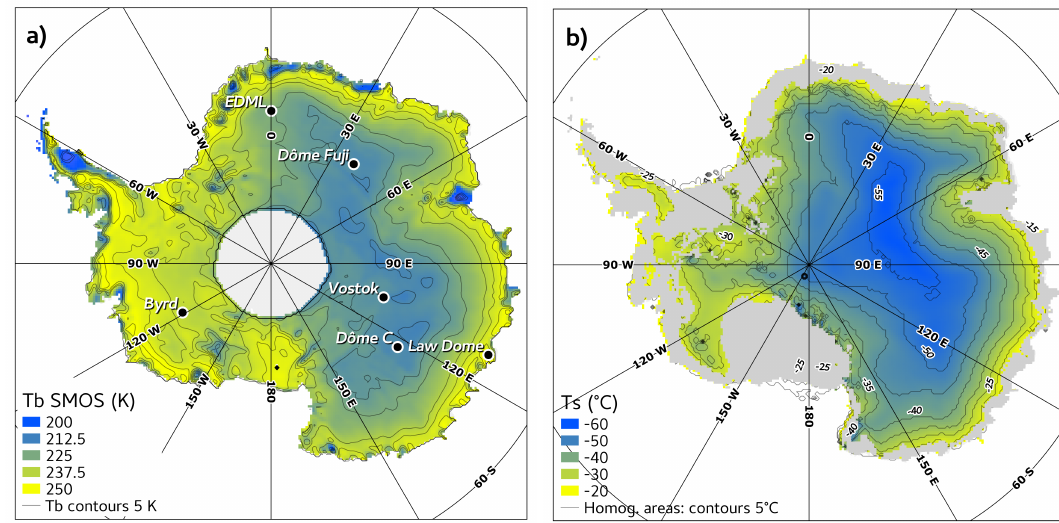
Figure 1. ( a ) Brightness temperature T B measured by the Soil Moisture and Ocean Salinity (SMOS) satellite sensor at the L-band and vertical polarisation, averaged over two years (2013–2014). Black contours are 5 K apart. ( b ) Surface temperature T s (K) from the Crocus snowpack model. Contour lines are 5 ◦ C apart and delineate the thermally homogeneous areas used in the retrieval algorithm. Areas undergoing more than five days of melt over the 1979–2007 period are masked in grey and are not accounted for in the